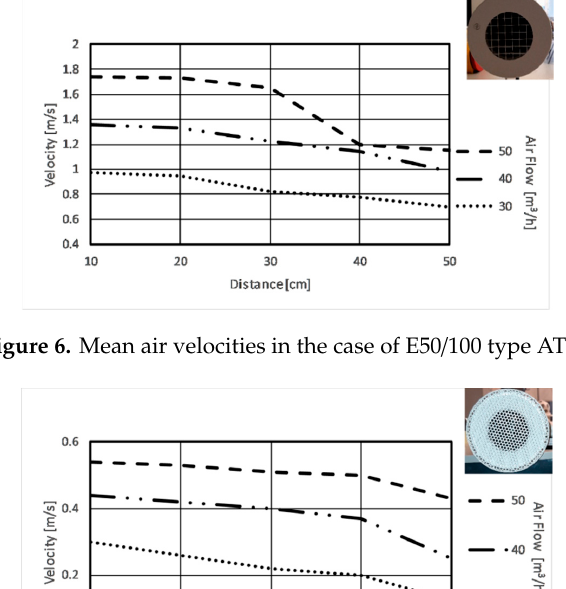
Figure 5. Mean air velocities in the case KV 100 type ATD.